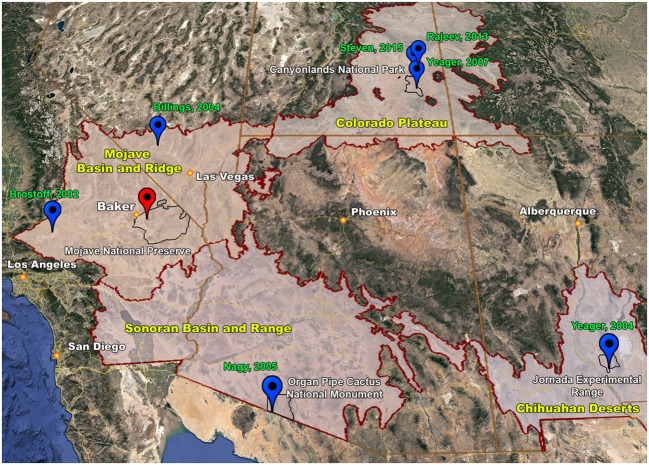
Biogeography of selected biological soils crusts (BSCs) in the southwestern United States; map shows the location (red icon) of BSCs characterized in this report (high-density site), the locations (blue icons) of other phylogenetically characaterized BSCs in the region (Author, year), the boundaries (maroon lines) of ecoregions defined by the Environmental Protection Agency (e.g., Mojave Basin and Ridge, Colorado Plateau, Sonoran Basin and Ridge, and Chihuahuan Deserts), and the boundaries (black lines) of associated national/federal lands; digital map was prepared using Google Earth Pro (7.3.0.3827, 64-bit), where GPS coordinates of the phylogenetically characaterized BSCs (blue icons) were obtained from the respective literature reports, boundary geographic data were downloaded from https://geodata.epa.gov/
https://catalog.data.gov
https://jornada.nmsu.edu/ and all labels, and anotations added using Adobe Photoshop CC (2017.0.1 Release).